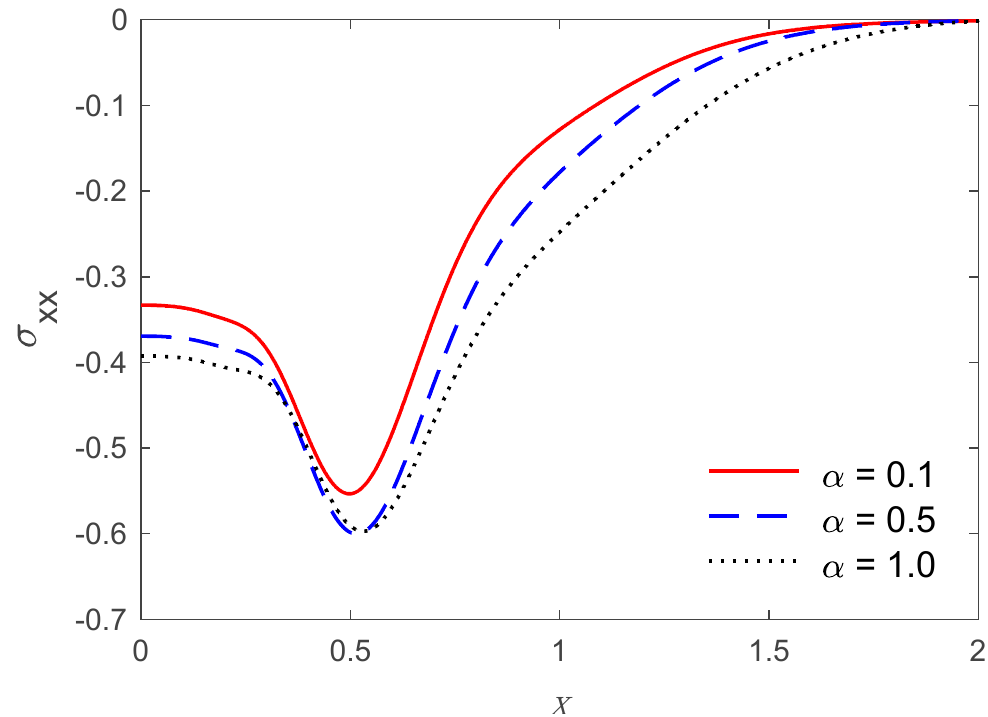
Figure 6. The variations of stress of solid distributions 𝜎 (cid:3051)(cid:3051) via 𝑥 for three values of fractional parameter.